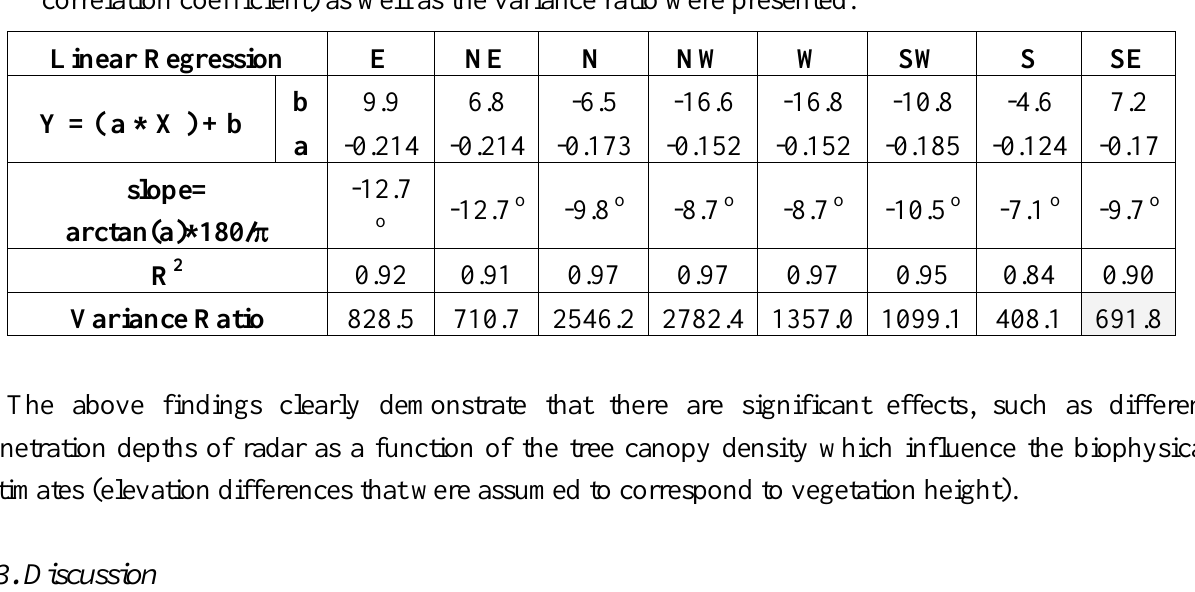
Table 2. Linear regression of mean elevation difference (Y) per 1% width sub-pixel tree canopy density (X) per geographic direction. The linear regression coefficients (a and b), the slope of regression line expressed in degrees, the R square (R corresponds to the correlation coefficient) as well as the variance ratio were